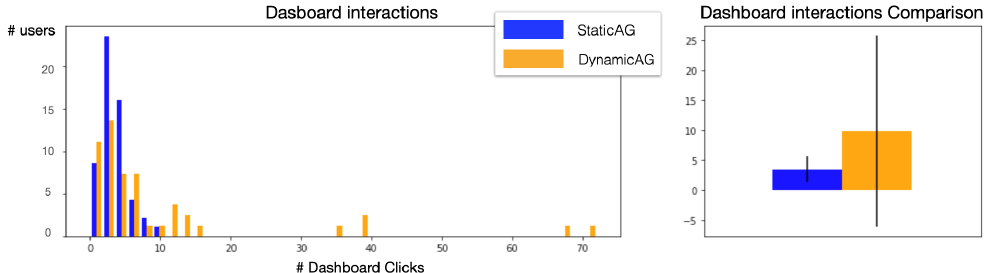
Figure 6. Comparison of Dashboard Clicks . Left side: histogram. Right side: the mean of the number of clicks and the variance of all students in each group. “# users” means number of users